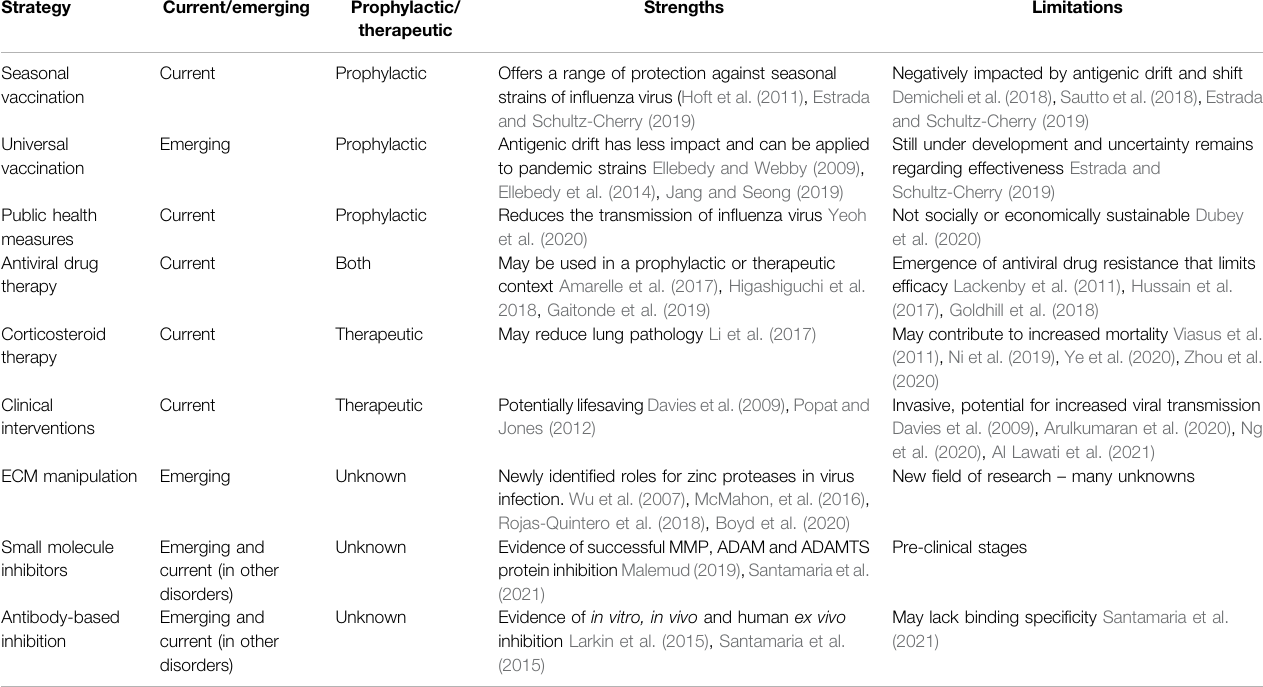
TABLE 1 | Evaluation of current and emerging therapeutics for in fl uenza virus